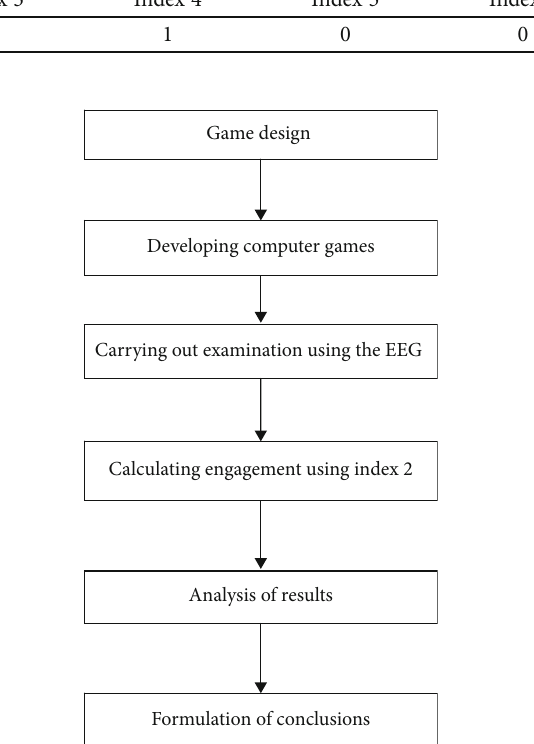
Figure 13: Test procedure to determine if a person likes to play arcade games.